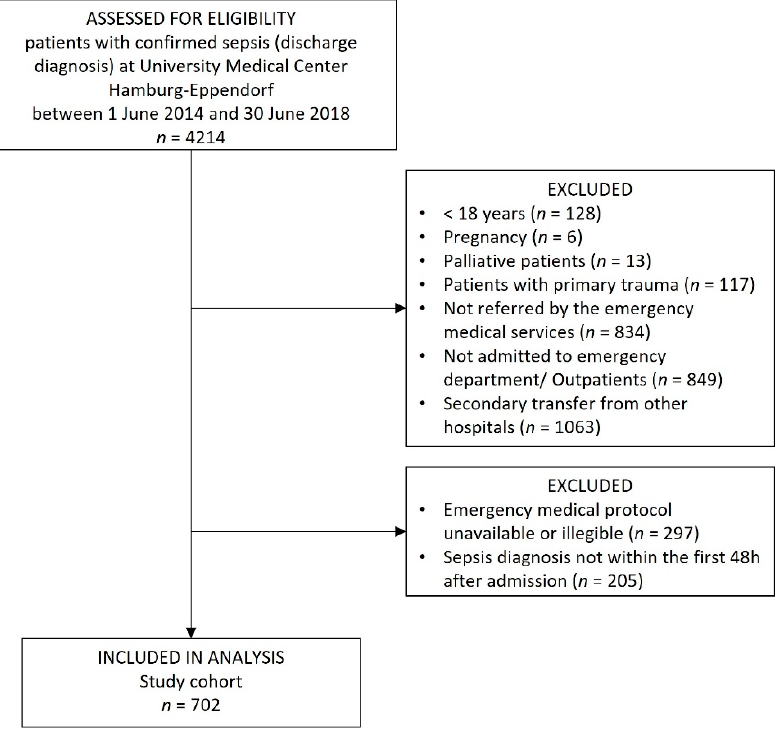
Figure 1. Study flow.